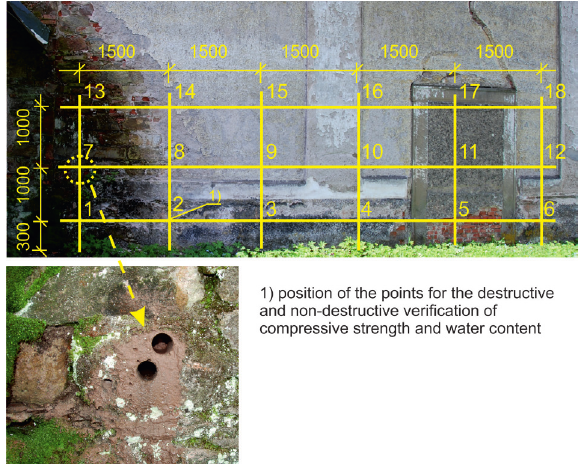
Fig. 3. An example of an investigated masonry structure with a marked virtual network – a wall of the church from the 17 th century in Fořt, Czech Republic Table 1. Strengths of sandstone, bricks and mortar [MPa] Masonry units Mortar Location